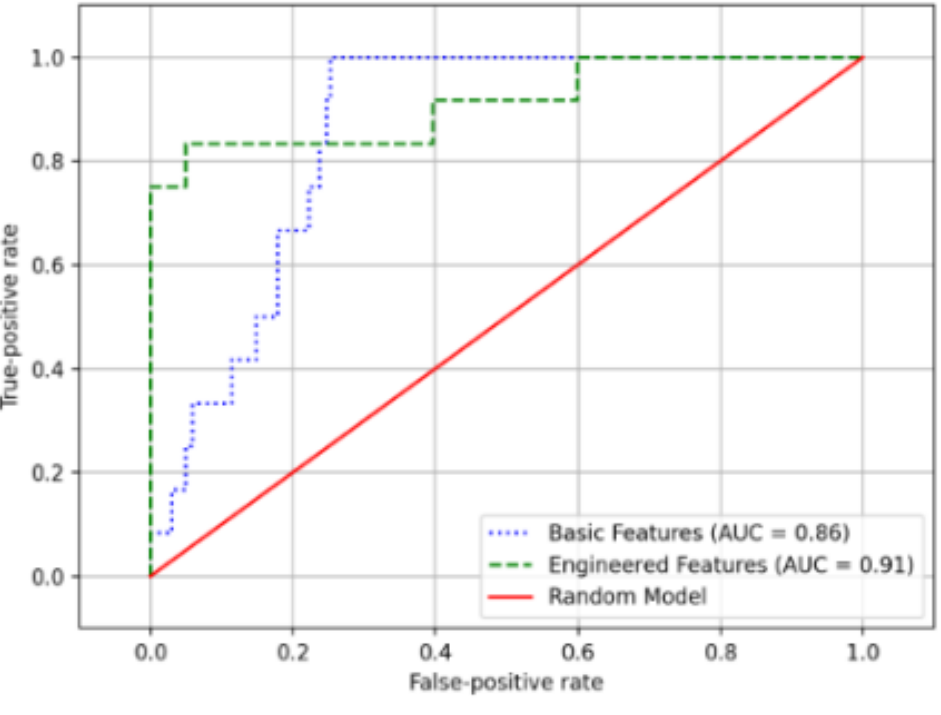
Figure 6. Receiver-operating characteristic curves displaying the ability of the algorithms to classify a train-of-four measurement as an outlier. AUC: area under the